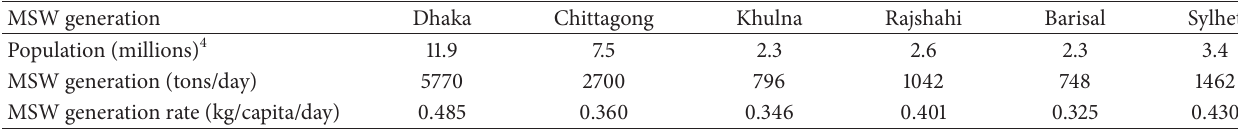
Table 6: MSW generation in six major districts of